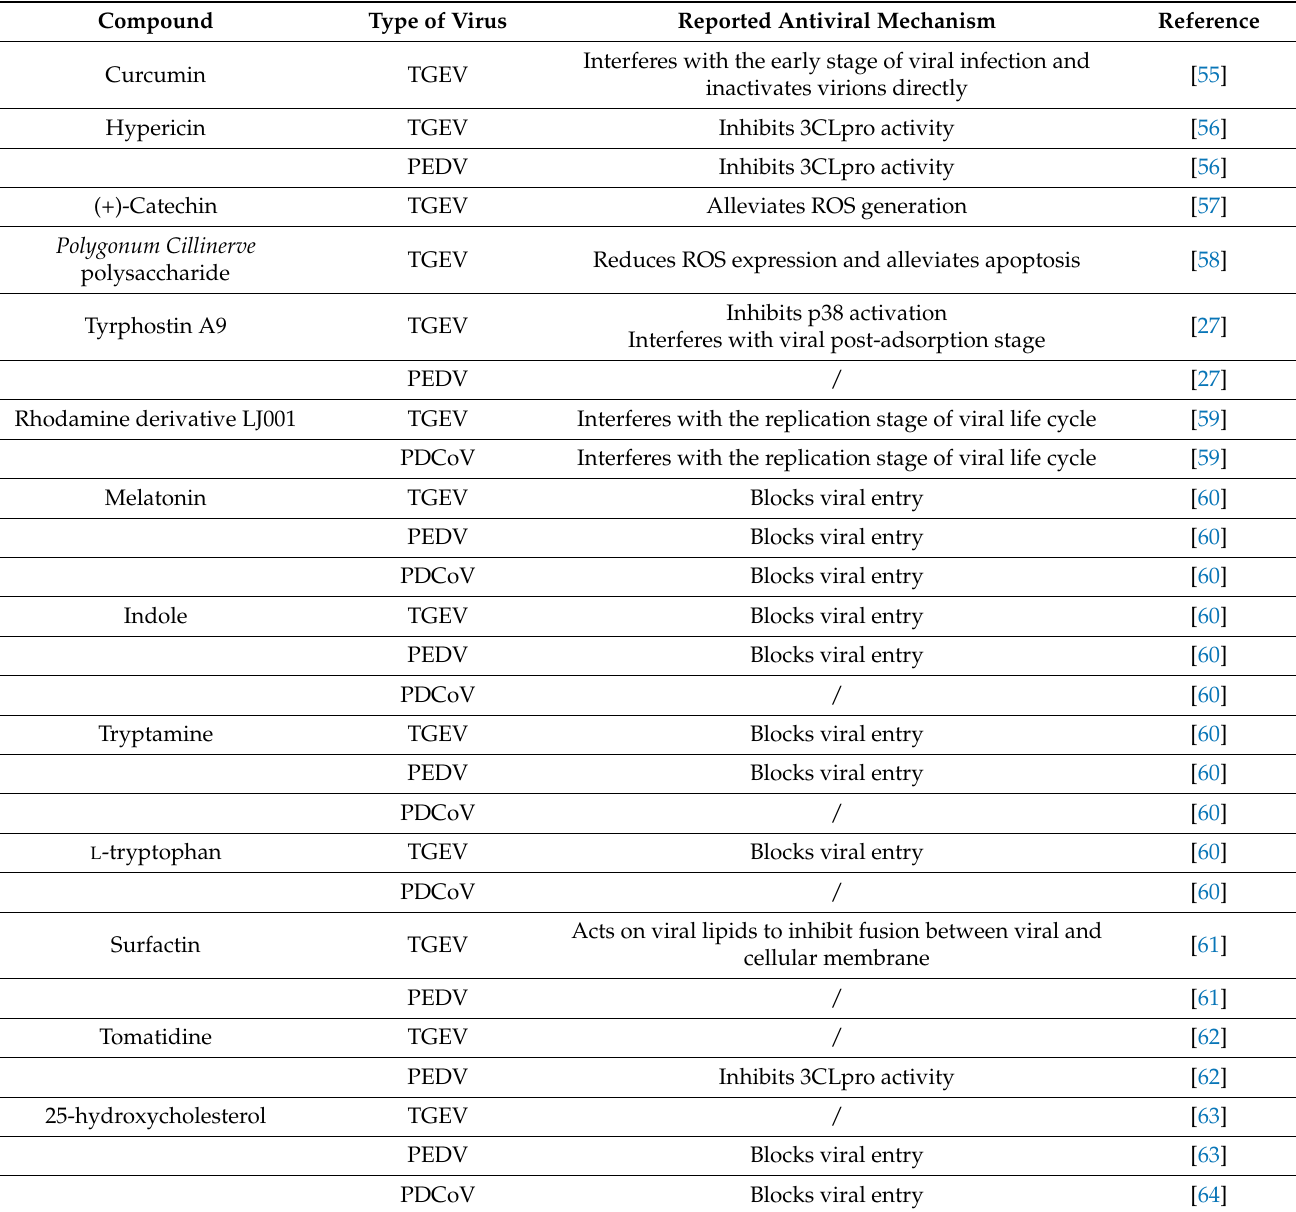
Table 1. Bioactive compounds with anti-PECoV activity and their possible action